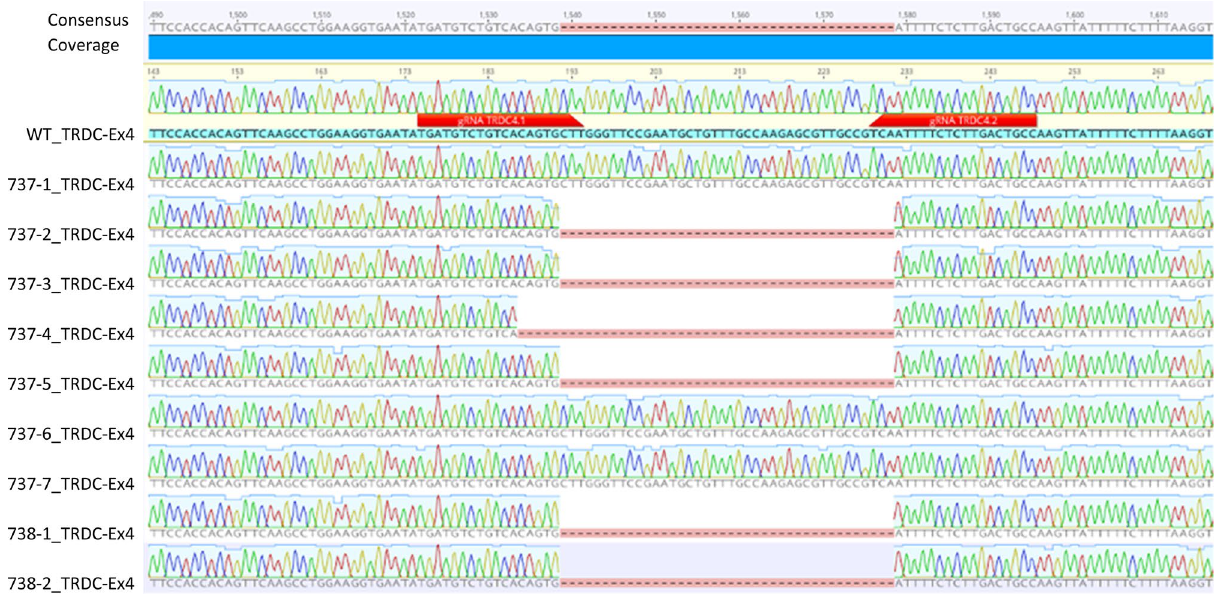
Figure 4. Sequencing results of the cloned liveborn TRDC knockout pigs. Pig 737-4 differed regarding the genetic modification compared to the other TRDC knockout pigs with a larger deletion encompassing 45 bp, indicating its origin from a separate cell subclone. The binding sequences of the guide RNAs are indicated by red arrows.